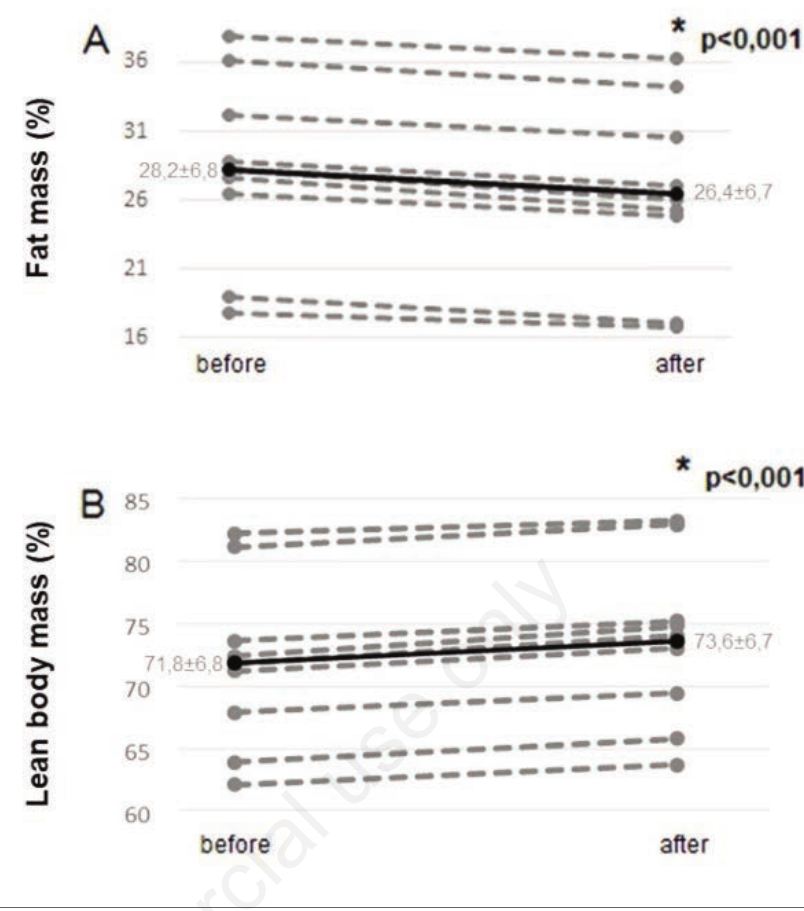
Figure 1. Variation of fat (A) and lean body mass (B) percentages of patients living with HIV/AIDS before and after submission to the training period. Full lines indicate the mean variation of all patients evaluated; dotted lines indicate the individual data of each study participant. P-value calculated by the Paired T test for related